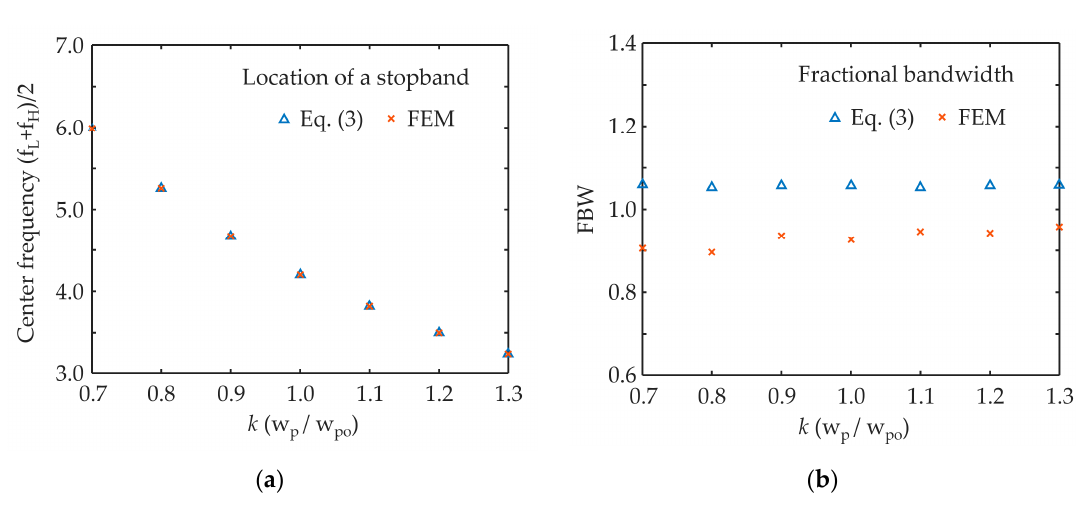
Figure 6. Analysis of the w p effects on the low- and high-cutoff frequencies.